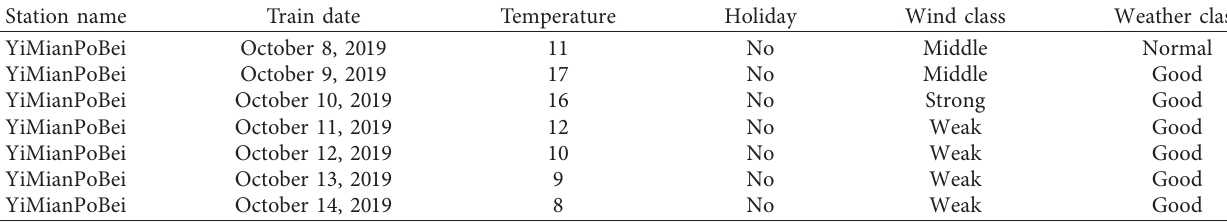
Table 6: Historical weather data and holiday data (after classification).